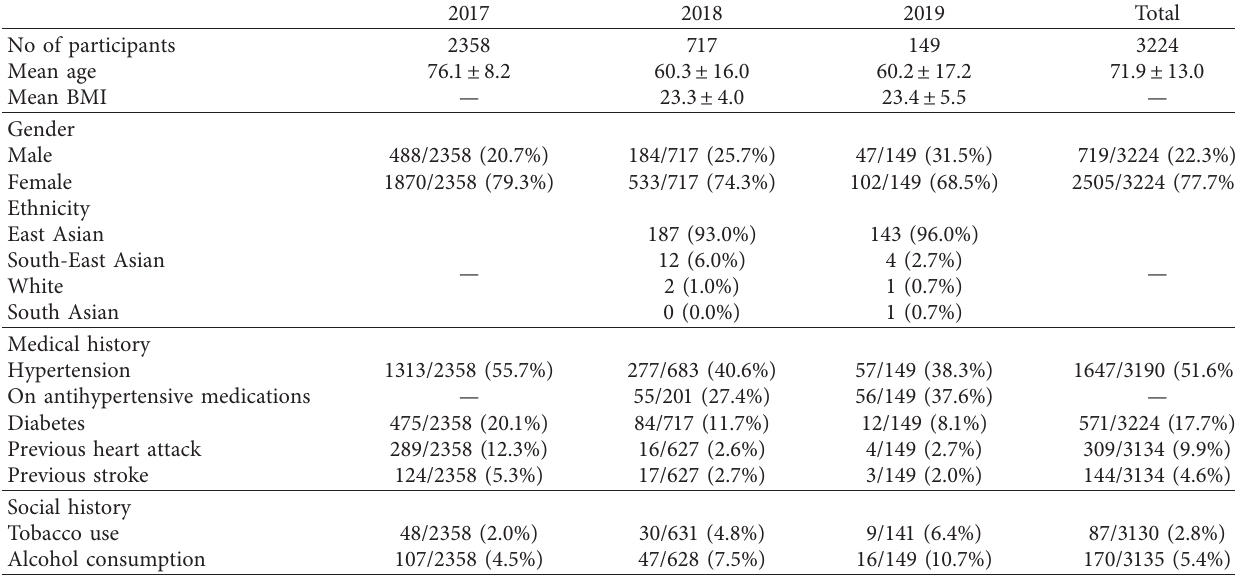
Table 1: Participant demographics.